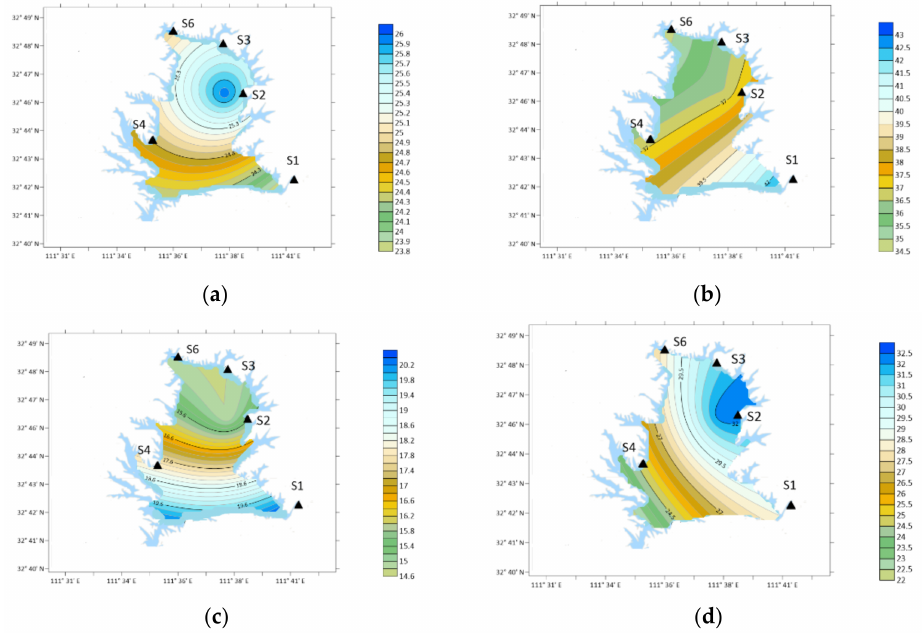
Figure 7. Spatial variation of DEA concentration. ( a ) Winter; ( b ) spring; ( c ) summer; ( d )